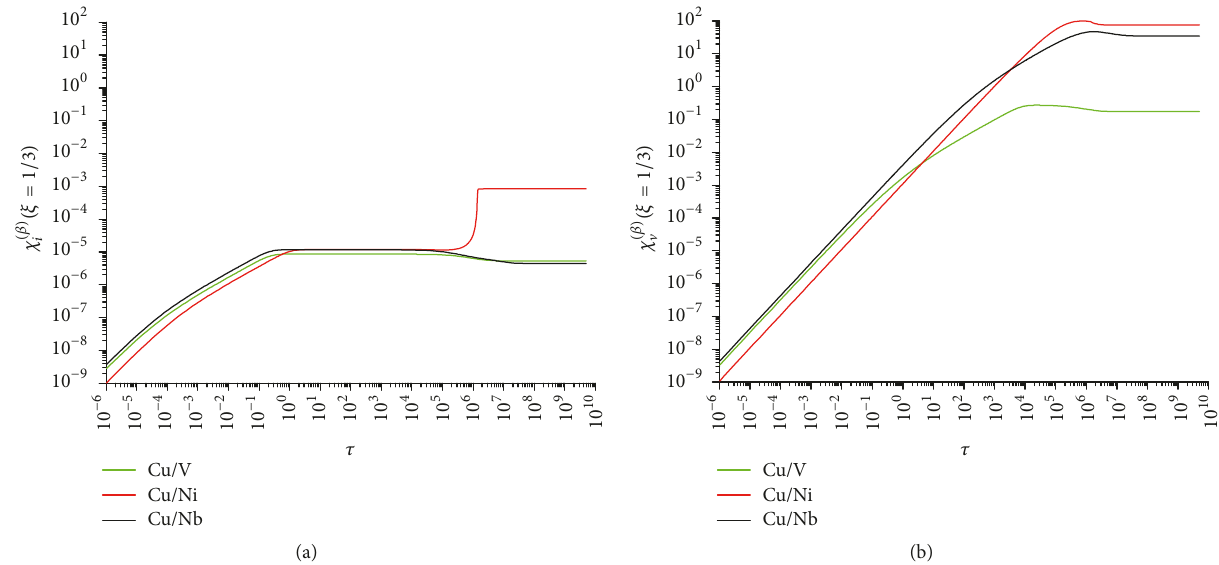
Figure 8: Temporal profiles of (a) SIA and (b) vacancy concentration in layer 𝛽 at the interface between metals 𝛼 and 𝛽